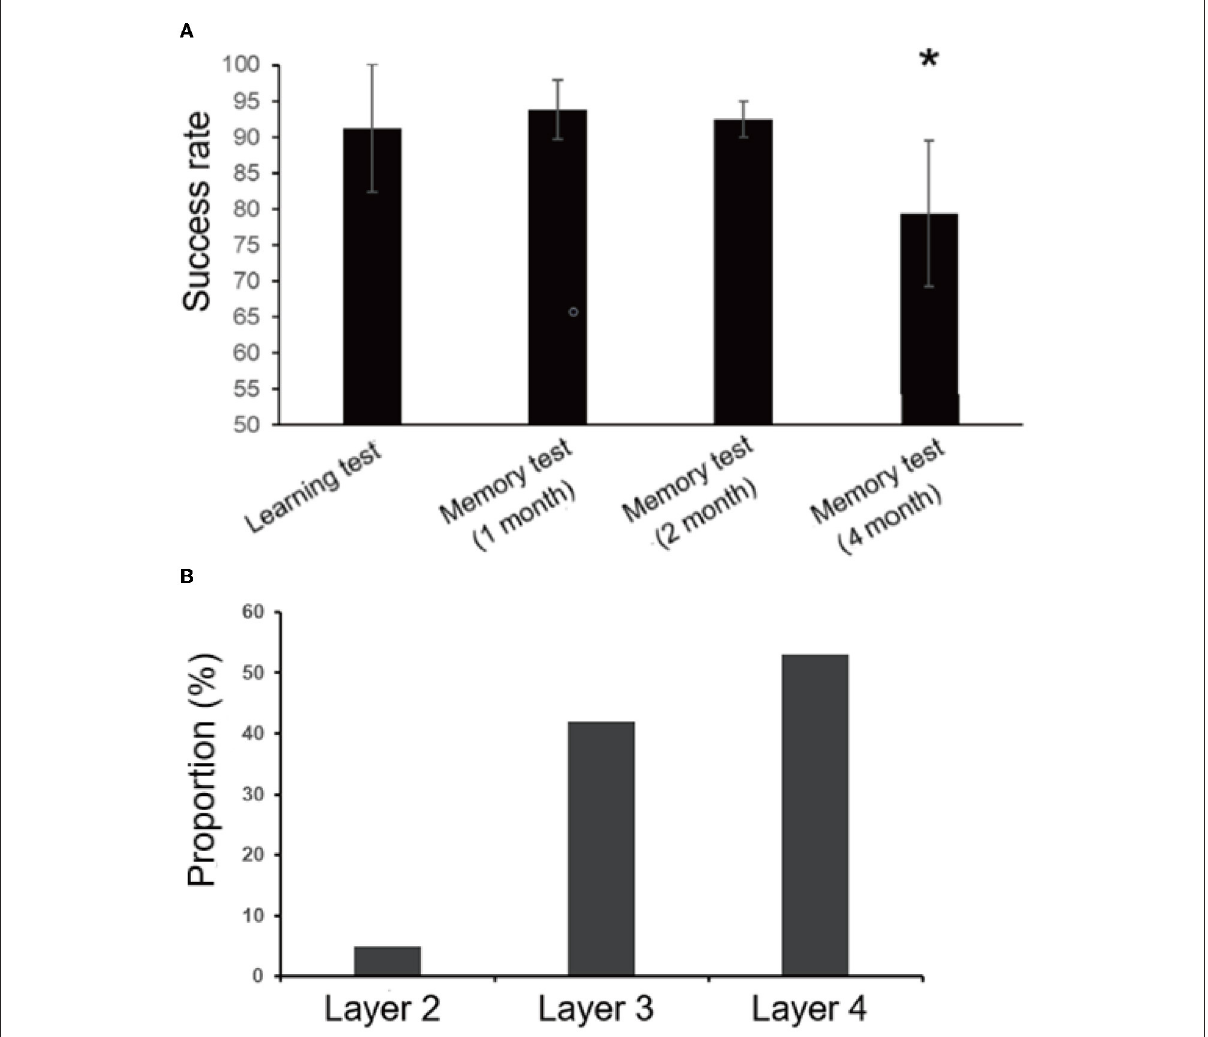
FIGURE6 Results of the learning and memory test. (A) There was no significant difference between the learning test and the memory test in the first 2 months, but the success rate decreased significantly ( * p < 0.05) in the fourth month. (B) Most of the rewards that fell into the error box were placed on the fourth floor (53%), and the least on the second floor (5%) in the the memory tests. Rewards placed on the third layer account for